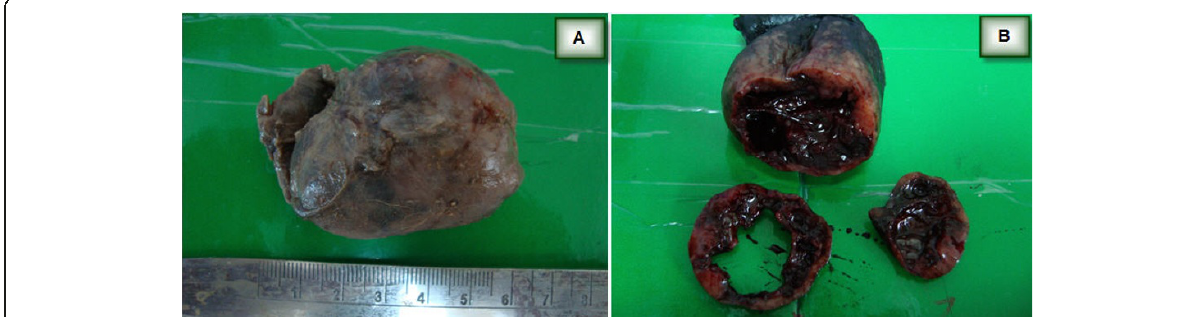
Figure 2 Gross photograph . (A) The tumor mass measuring 6.0 × 4.3 × 3.5 cm with the focal hyperpigmented external surface. (B) A cross section showing the central cystic change filled with dark friable